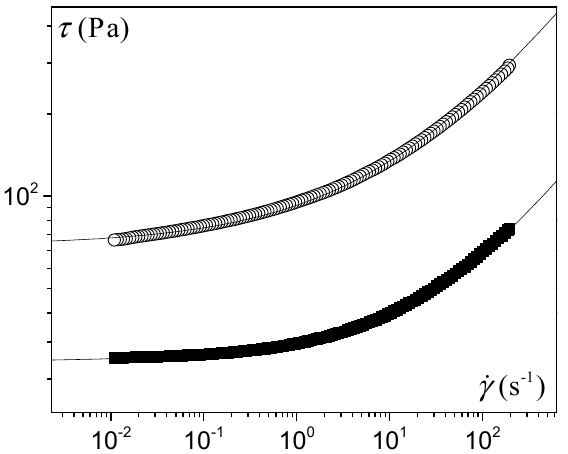
Figure 1. Typical flow curve of a one of our emulsion and of the Carbopol gel. The continuous lines are the Herschel–Bulkley model fitted to data with the parameters: (emulsion emulsion (78%)) τ c = 30 Pa, k = 4.5 Pa · s n and n = 0.45; (Carbopol) τ c = 70 Pa, k = 23.5 Pa · s n and n = 0.4.